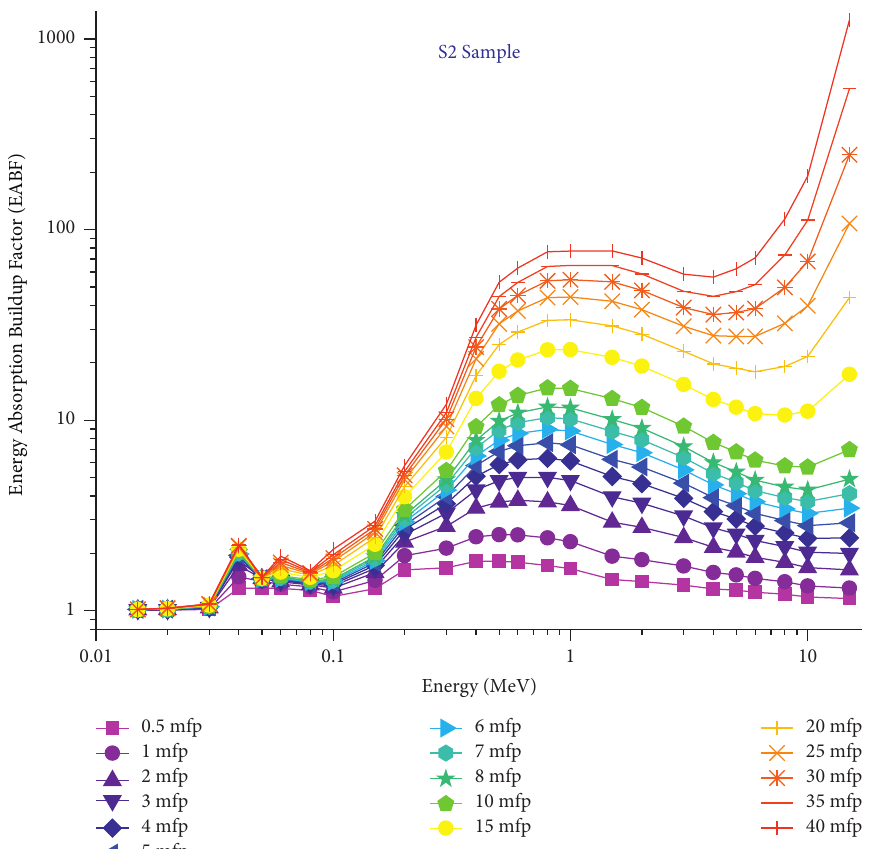
Figure 13: Demonstrates the relationship between the energy and EABF of the S2